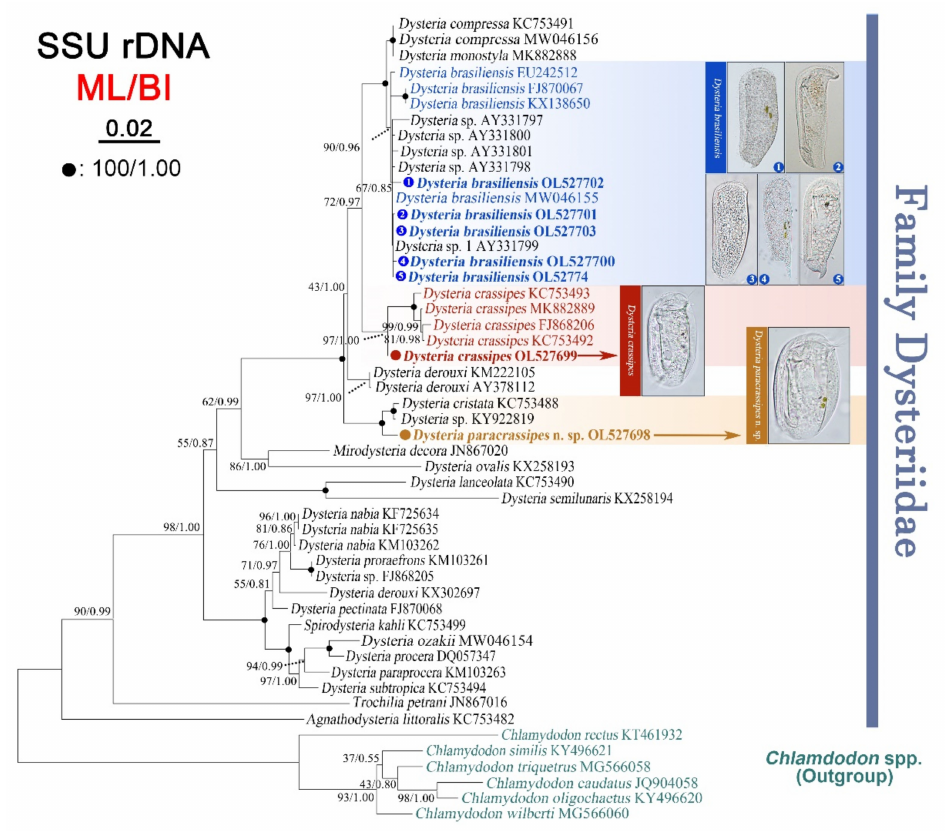
Figure 6. Maximum likelihood (ML) tree inferred from SSU rDNA sequences showing positions of Dysteria paracrassipes n. sp., Dysteria crassipes , and Dysteria brasiliensis (bold font). Numbers at nodes indicate the bootstrap values of maximum likelihood (ML) out of 1000 replicates and the posterior probabilities of Bayesian analysis (BI). Solid circles represent full bootstrap supports from both algorithms. The scale bar corresponds to two substitutions per 100 nucleotide